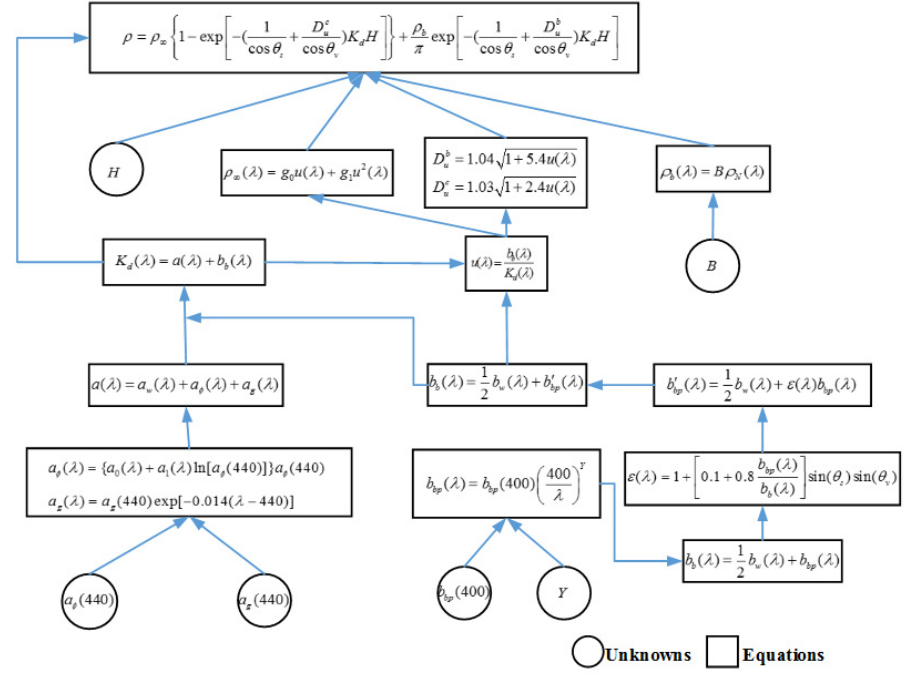
Figure 3. The semi-analytic bathymetric model used by Eugenio et al. [38]: a and b b are the attenuation coefficients and the backscattering coefficient, respectively; a w , a φ , and a g are the attenuation coefficients for water, phytoplankton, and gelbstoff, respectively; b w and b bp are the backscattering coefficients for water and particles, respectively; u is the backscattering diffuse attenuation ratio; ε is an empirical parameter to account the effect of changing angle on the effective scattering; and ρ N is the 550-nm-normalized sand-albedo